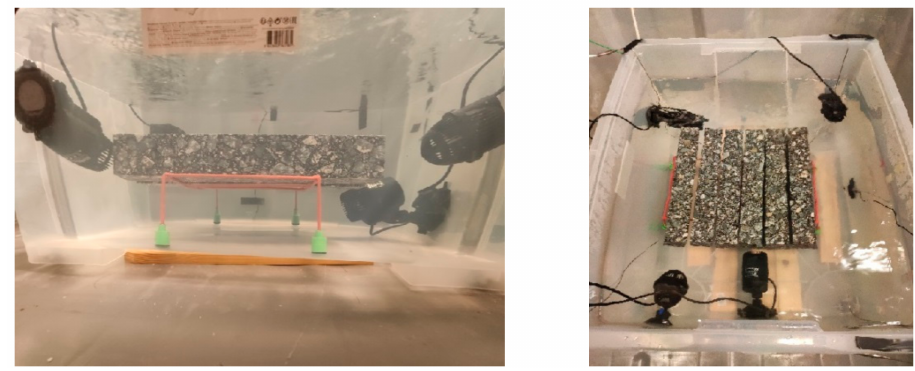
Figure 2. Fully armed container prepared to